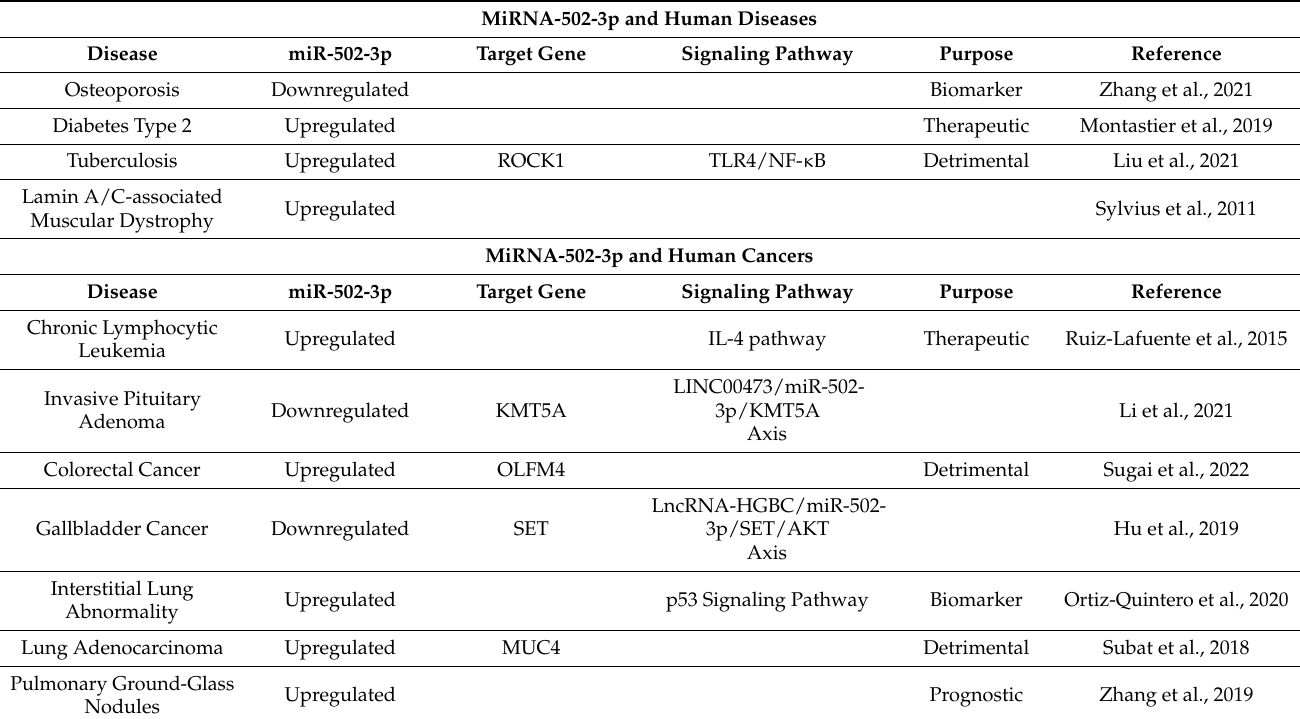
Table 1. Details of miRNA-502-3p in various human diseases, their status, target genes, signaling pathways, and study